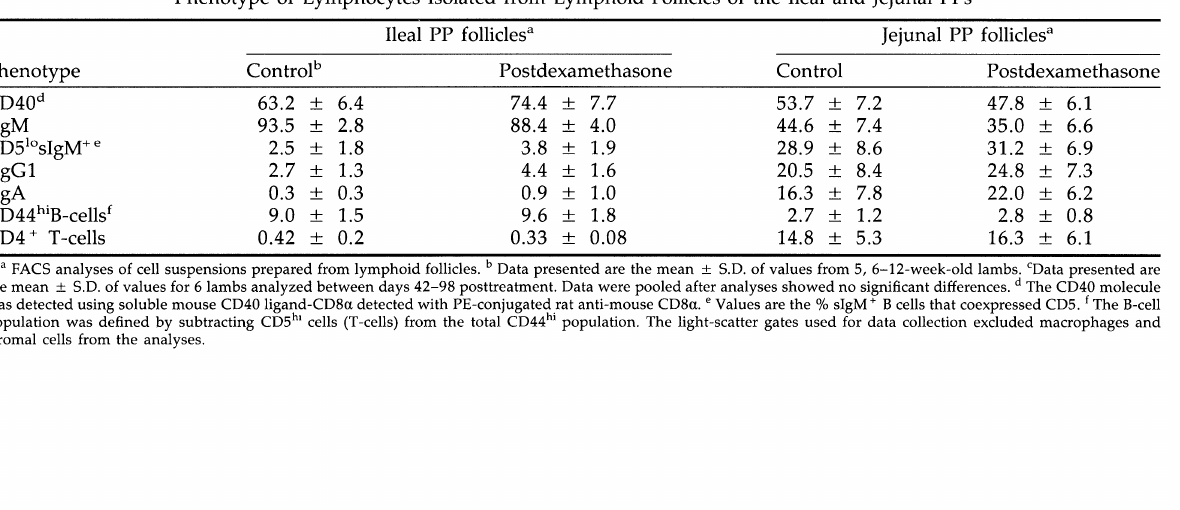
TABLE Phenotype of Lymphocytes Isolated from Lymphoid Follicles of the Ileal and Jejunal